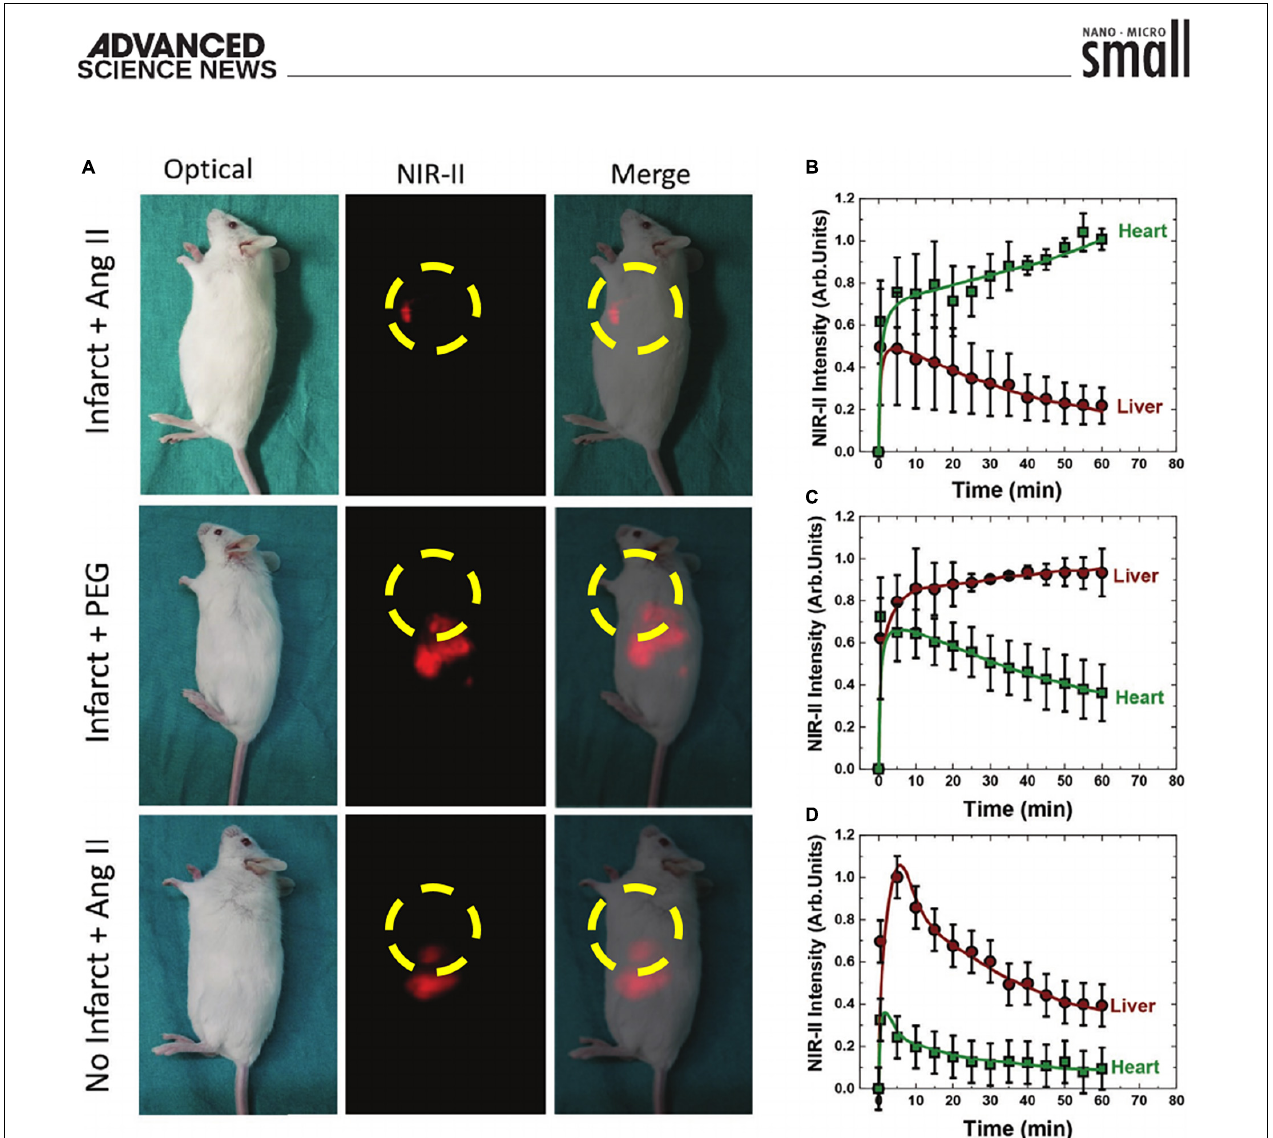
FIGURE 1 | (A) Top row of panels: optical, NIR-II fluorescence, and merged image of targeting Ag 2 S-Ang II NDs (10 min post-administration) primarily accumulating at site of induced acute myocardial infarct in a murine model. Middle row of panels: optical, NIR-II fluorescence, and merged image of PEGylated-Ag 2 S NDs (10 min post-administration) non-specifically accumulating primarily at the liver. Bottom row of panels: optical, NIR-II fluorescence, and merged image of targeting Ag 2 S-Ang II NDs non-specifically accumulating primarily at the liver in a murine sham (i.e., no infarct) model. Imaged organ within yellow dashed circle highlights the heart. Please note that the location of the heart between images shifts due to the murine model being in a different rotated position. (B–D) Corresponding time course (60 min) of the NIR-II fluorescence intensity generated in the heart and liver following NDs administration. (A–D) Reproduced with permission (Mateos et al.,